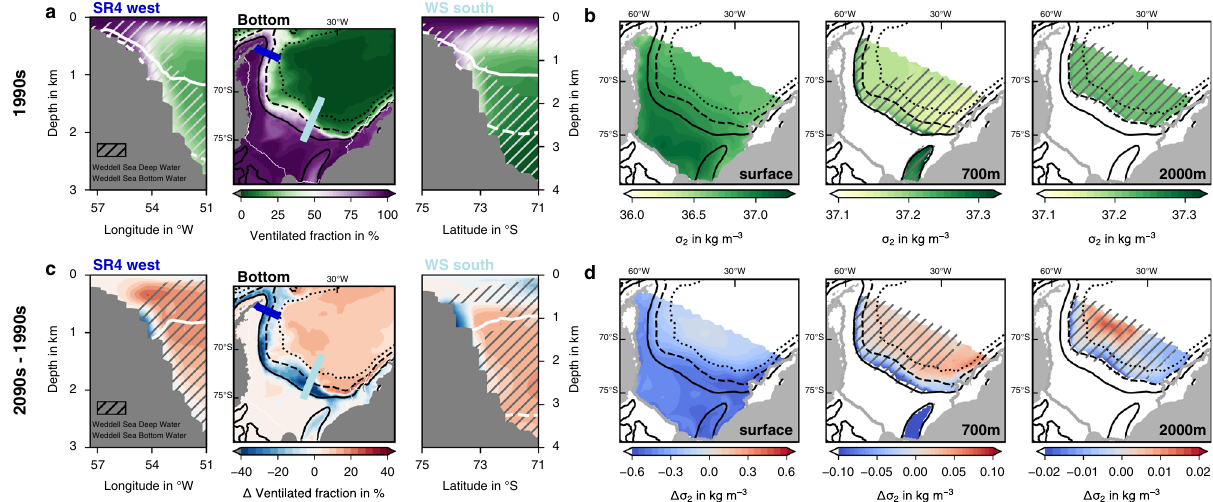
Fig. 4 Bottom water ventilation and density distributions. a Age-tracer-based fraction of water that is ventilated at the bottom (middle) and across the continental slope in the western (SR4 west; left) and southern Weddell Sea (WS south; right) in the 1990s of simA (historical + SSP5-8.5 scenario). The positions of the transects are indicated in the map as the dark blue (SR4 west) and the light blue line (WS south), respectively. b Distribution of potential density anomalies ( σ 2 in kg m − 3 , i.e., potential density referenced to 2000dbar minus 1000 kg m − 3 ) at the surface, 700 m, and 2000 m in the 1990s. Note the different scales. c , d Same as a , b , but for the change in c the ventilated fraction and d σ 2 between the 2090s and the 1990s. In the transects in a , c , σ 2 isolines for the a 1990s and c 2090s are shown as the solid (37.2kg m − 3 ) and dashed (37.25 kg m − 3 ) white contour, respectively. In all maps, black contours show the 700 m (solid), 2000 m (dashed), and 3500 m (dotted) isobaths. Hatching denotes the presence of Weddell Sea Deep Water and Weddell Sea Bottom Water in the a , b 1990s and c , d 2090s, de fi ned in the model as waters with a potential temperature < − 0.2 ∘ C and a practical salinity